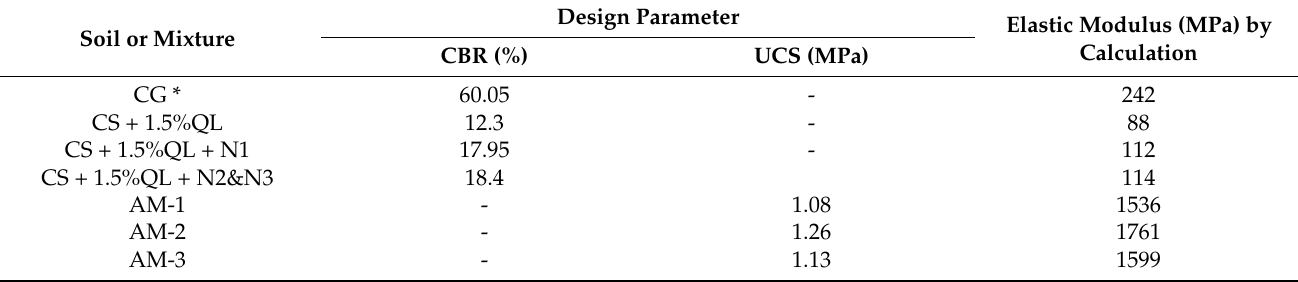
Table 5. Elastic modulus, E (MPa), of the soils or mixtures. Design Parameter Elastic Modulus (MPa) Soil or Mixture